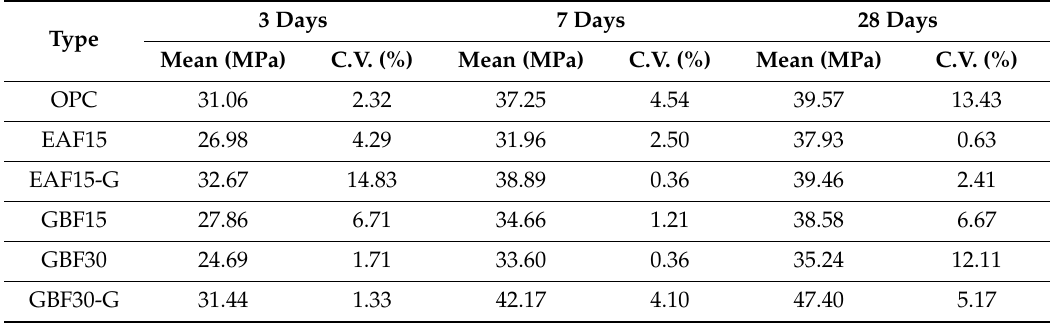
Table 5. Results of compressive